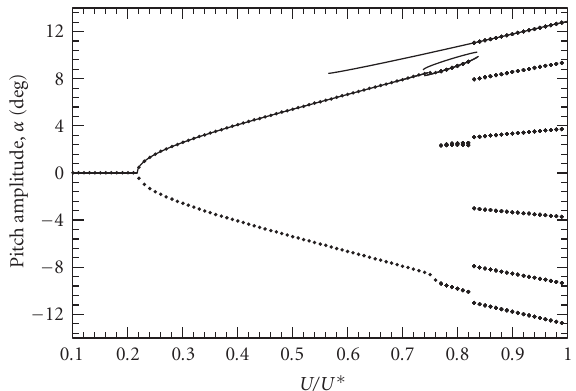
Figure 5: Comparison of the bifurcation diagrams obtained via the defect-controlled method and AUTO. • , defect-controlled results; —, AUTO (stable